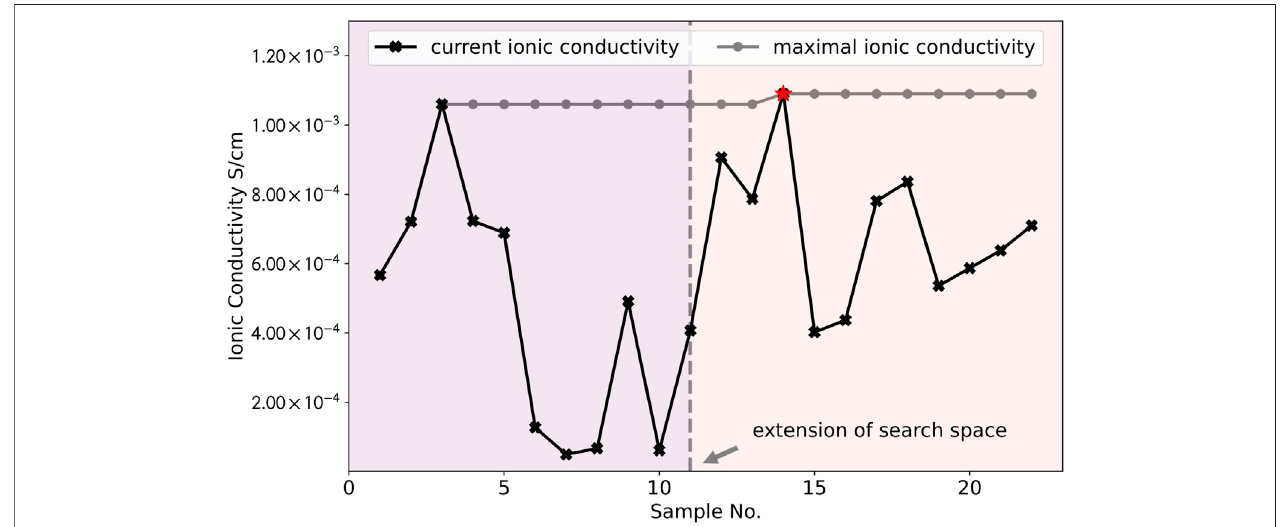
FIGURE 4 | The values of ionic conductivity for each sample (black line) during the four iterations and the values of the maximum (grey line). The results of experimentsshowa fl uctuatingtrend,re fl ectingtheexplorationvs.exploitationintheoptimizationprocess.Theoverallresultexhibitsastep-wiseupwardtrendanditcan be seen that the model has found the largest values of ionic conductivity (marked as red star) within several iterations.